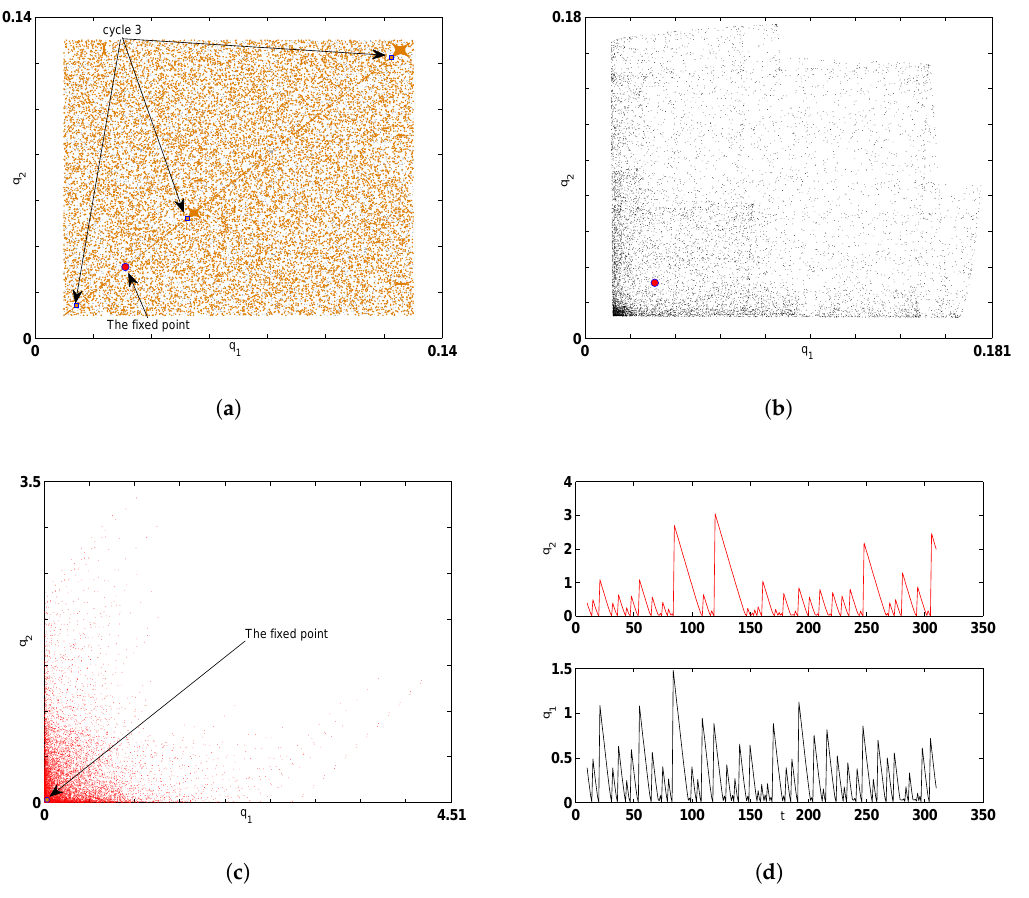
Figure 5. ( a ) Basin of Attraction of period 3-cycle at k = 31.7156; ( b ) Basin of Attraction of chaotic attractor at k = 33; ( c ) Basin of Attraction of chaotic attractor at k = 40.1; ( d ) time series for both variables for the chaotic attractor in ( c ) at k =